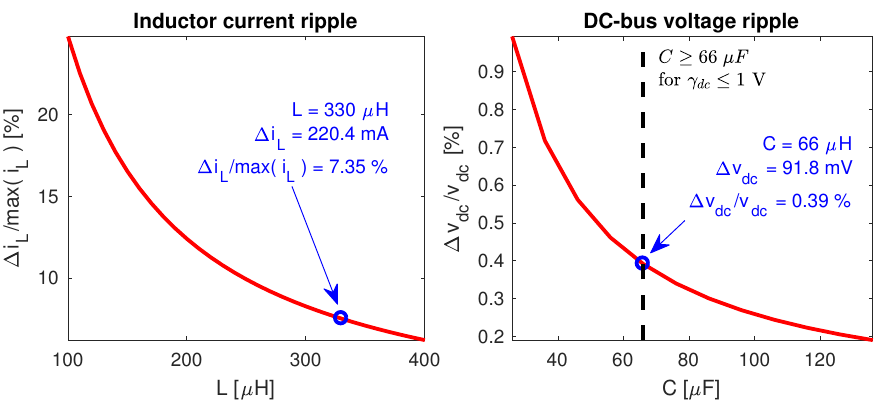
Figure 10. Inductor current ripple for different inductance values ( left ) and DC-bus voltage ripple for different capacitance values ( right